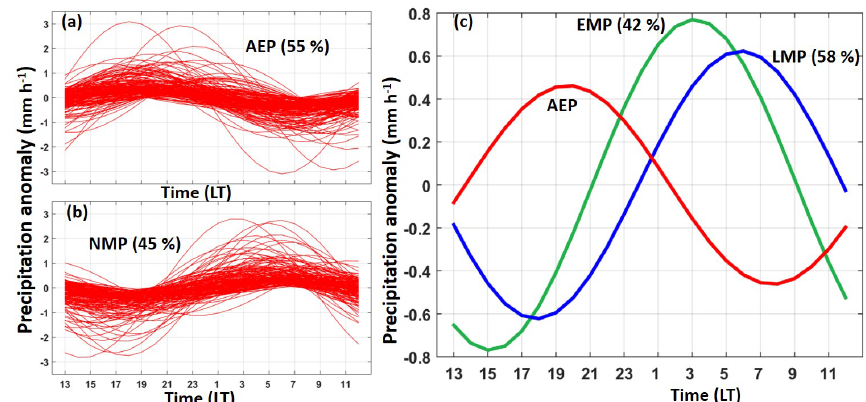
Figure 3. The first harmonic components analysed from diurnal precipitation data that are grouped into (a) afternoon-to-evening precipitation (AEP) between 13:00 and 24:00LT and (b) night time-to-morning precipitation (NMP) between 01:00 and 12:00LT based on the phase angles (see text for explanation); (c) composite sinusoidal curves of AEP (red line) with those of NMP split into early morning precipitation (EMP) between 01:00 and 04:00LT and late morning precipitation (LMP) between 05:00 and 12:00LT. Percentage indicates frequency of occurrence relative to total samples for AEP and NMP, but those of EMP and LMP are relative to NMP samples.